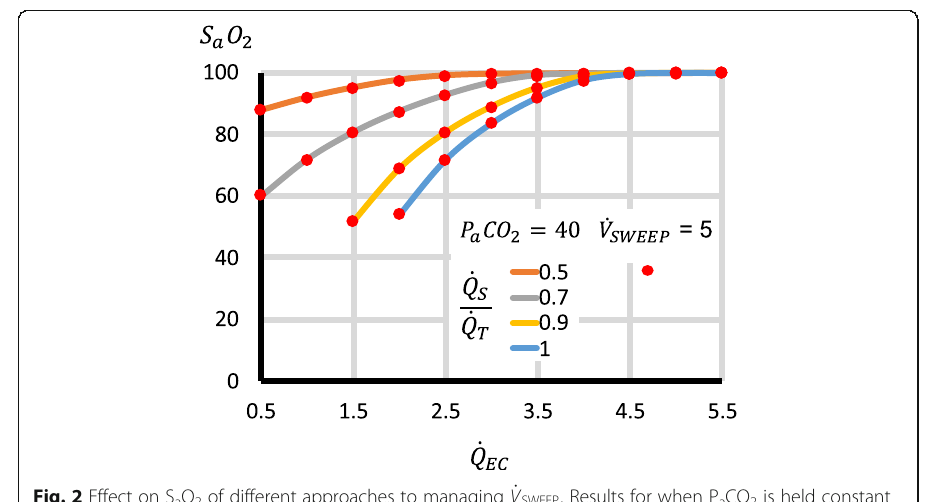
Fig. 2 Effect on S a O 2 of different approaches to managing _ V SWEEP . Results for when P a CO 2 is held constant at 40 mmHg by varying _ V SWEEP (continuous lines) compared to when _ V SWEEP is held constant at 5 l/min (data points as red markers). As _ Q EC increases, S a O 2 rises. The higher the